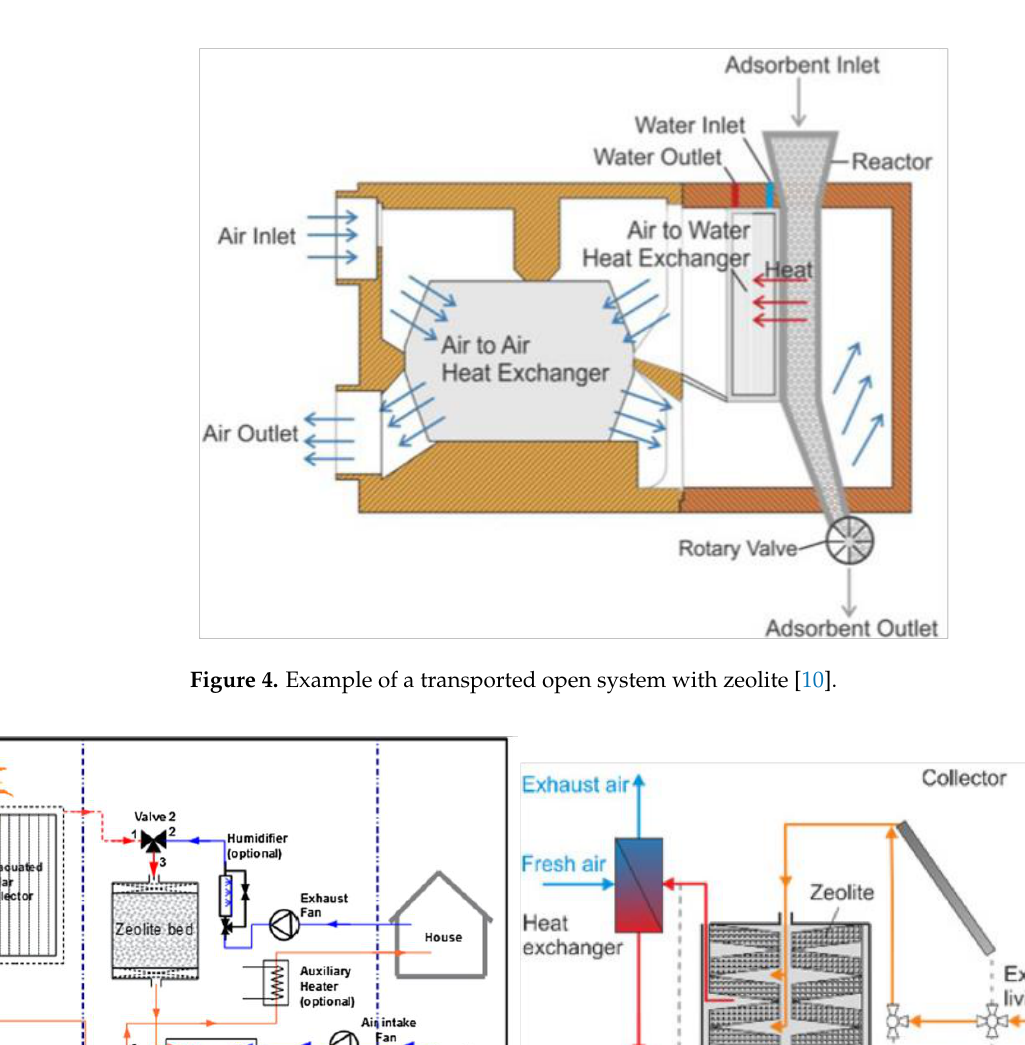
Figure 3. Illustration of the open fixed process with air to air heat exchanger and separated heat release, liquid on the left and air-bound on the right.